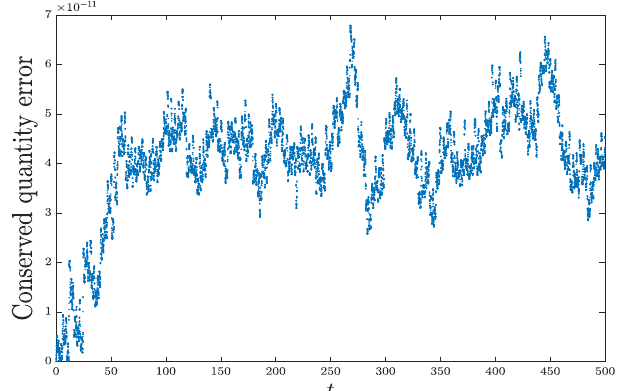
Figure 5. Errors in the conserved quantity H for Example 2 with h = 0.01.